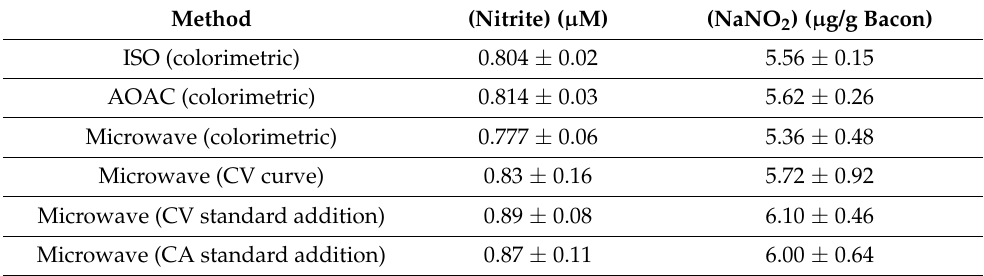
Table 1. Summary of the calculated concentrations of nitrites found in the same brand of commercial bacon using different methods. The values correspond to an average value obtained from three repeat measurements.